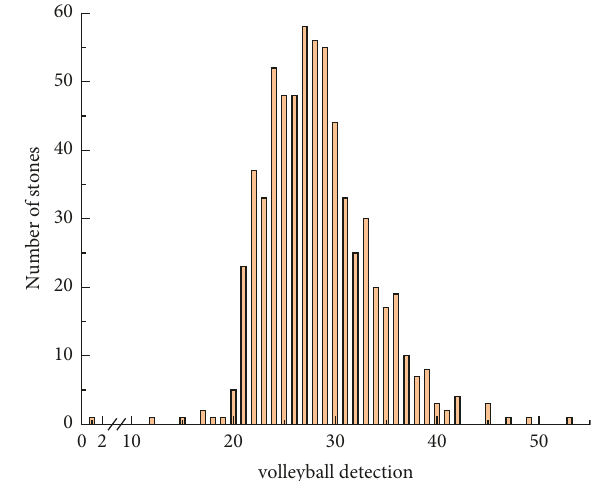
Figure 3: Distribution of eigenvalues of rock material shape-1.